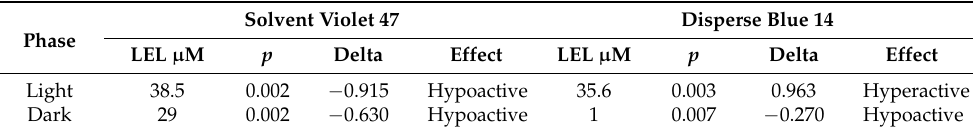
Figure 1. Summary of mortality at 24 h post fertilization (hpf) and 120 hpf in ( A ) Solvent Violet 47 and ( B ) Disperse Blue 14 treatment groups. * Indicates statistical significance ( p < 0.01) against the control (0 mg/L).